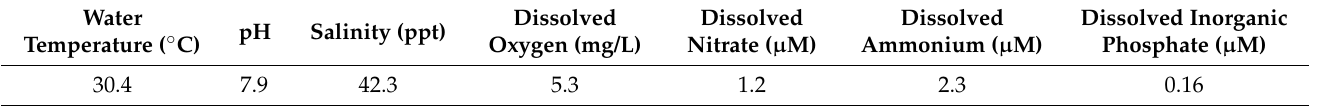
Figure 1. Seaweeds species images: Padina boergesenii : ( A ) whole thallus of the species and ( B) view in the natural habitat at the NIOF site. Turbinaria triquetra: ( C ) view in the natural habitat at the NIOF site and ( D ) whole thallus of the species. Hormophysa cuneiformis: ( E ) whole thallus of the species and ( F ) view in the natural habitat at the NIOF site. Dictyota ciliolata ( G ) view in the natural habitat at the NIOF site and ( H ) whole thallus of the species. Sargassum aquifolium ( I ) view in the natural habitat at the NIOF site and ( J ) whole thallus of the species. Table 1. Physiochemical characterization of the local of seaweed